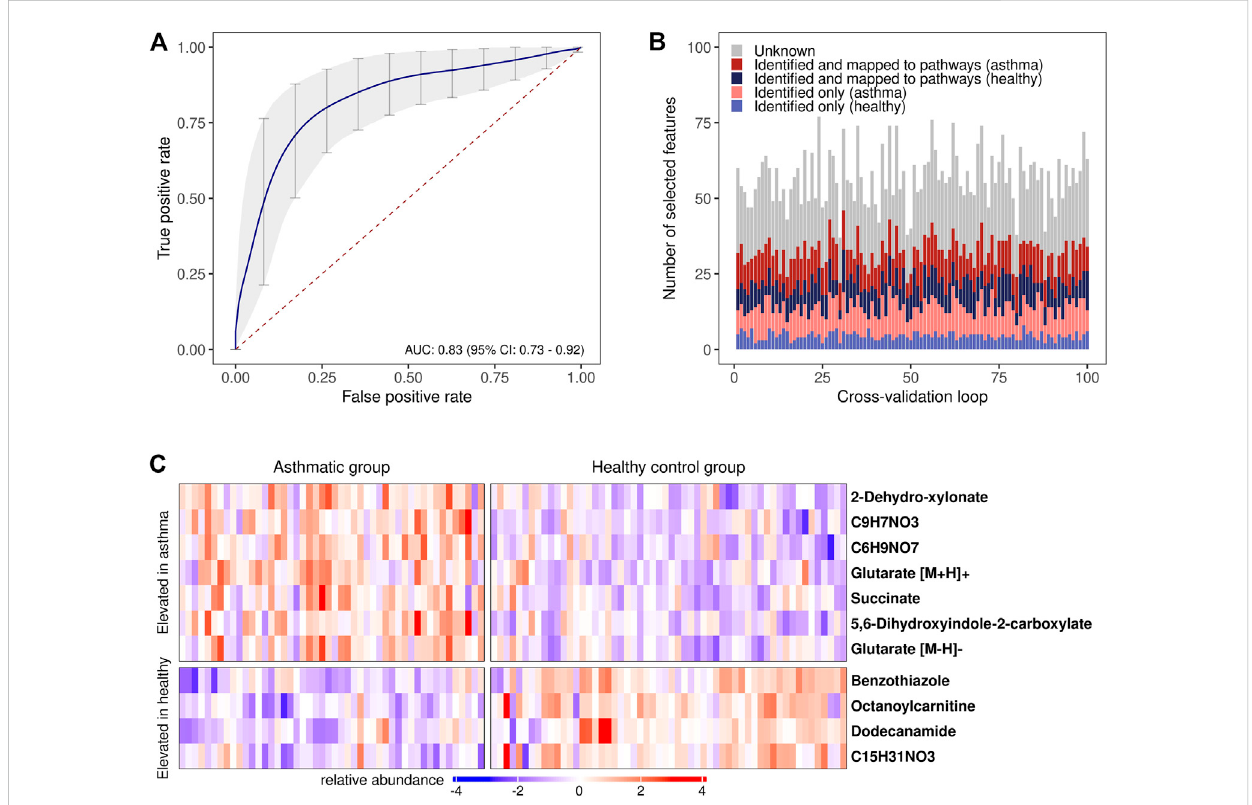
FIGURE 4 Disease prediction based on breath pro fi les. (A) Average receiver operating characteristic curve (ROC) with an average AUC of 0.83 resulting from the 10 times repeated 10-fold cross-validation.ROC curves resulting from predictions on each of the left-out data sets in thecross-validation were used tocalculatetheaverageROCcurve(Fawcett,2006)(verticalaveraging).Verticalgreybars:pointwisecon fi denceintervalscomputedusingbootstrapping (10.000 repetitions); red dashed line: line of no discrimination. (B) Stacked bar plots of the selected features in each cross-validation iteration. Red/ blue color scheme: upregulated features in the allergic asthmatic/healthy group. (C) Heat map of the most frequently chosen features (standardized intensities) as predictors in the cross-validation. Columns: study participants; rows: m/z features with putatively identi fi ed compounds (right), a chemical formula is provided if compound identi fi cation was not